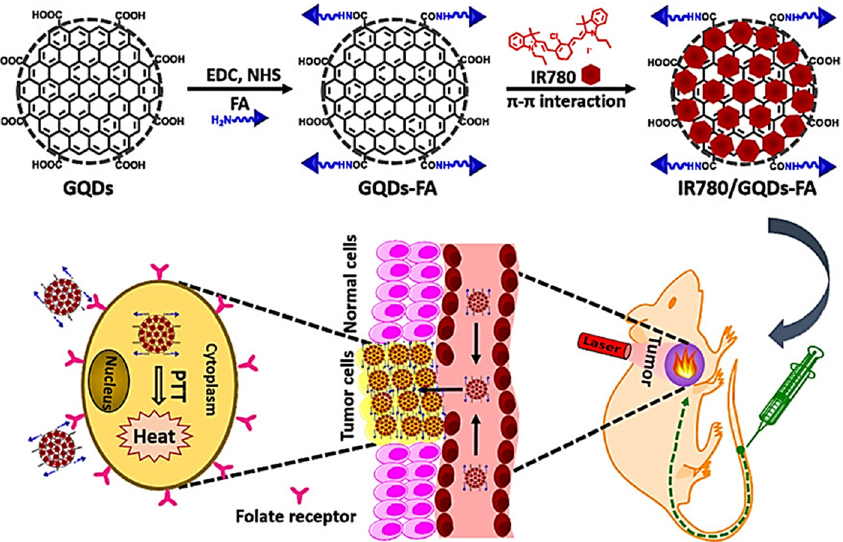
Figure 6. Loading IR780 iodide on folic acid (FA)-functionalized graphene quantum dots (GQDs) for targeted photothermal therapy (PTT). Reproduced with permission from [95]. Copyright 2017. American Chemical Society.